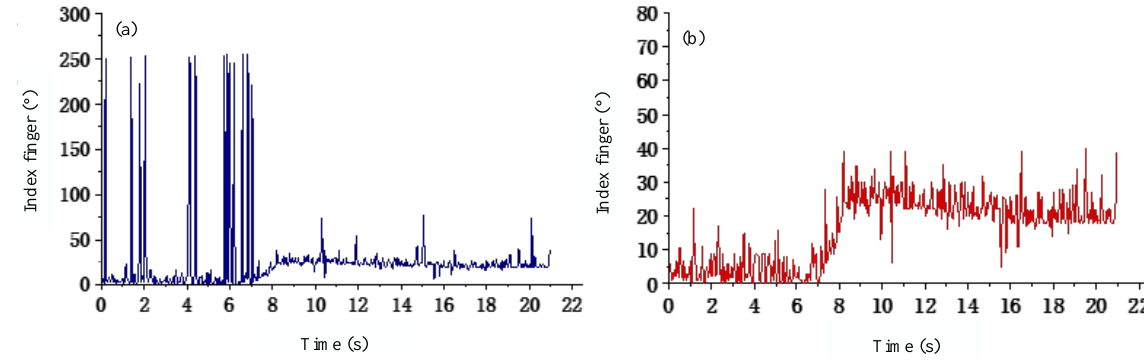
Figure 5. Index finger curvature. ( a ) Original data of curvature. ( b ) Preprocessed bending data.